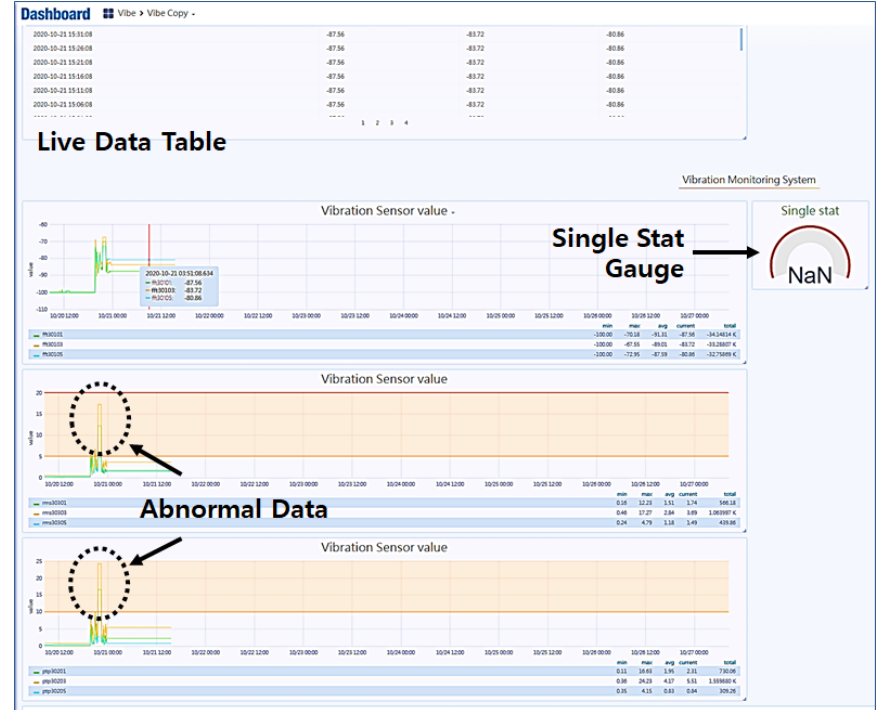
Figure 5. Dry pump vibration data monitoring system.